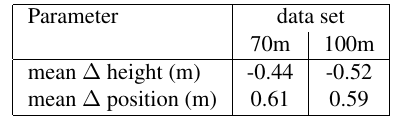
Table 3: Averaged height and position deviations between refer- ence and modeled palms for both data sets (70m and 100m).